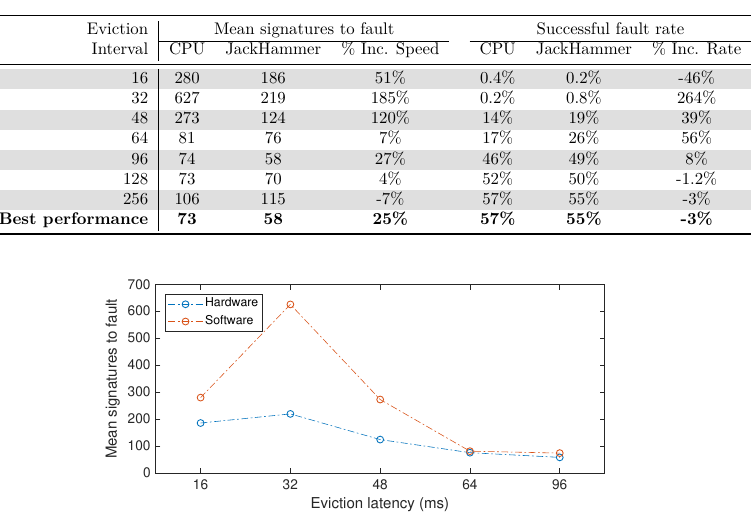
Figure 10: Mean number of signatures to fault at various eviction